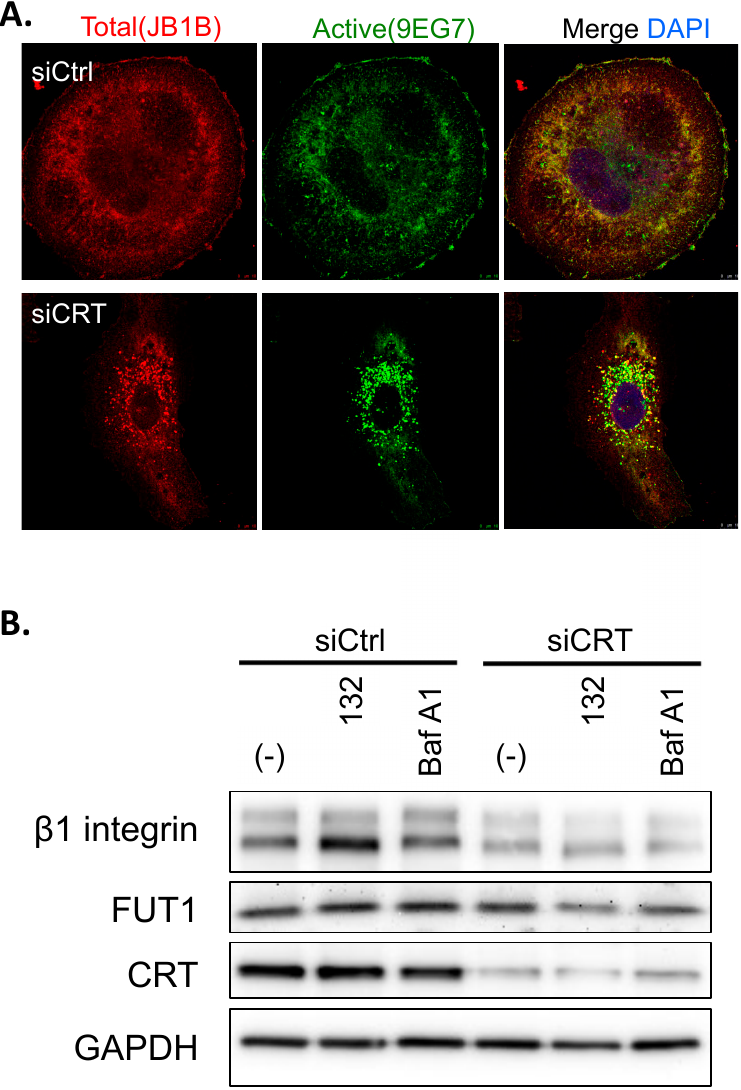
Figure 4. Knockdown of CRT induces β 1-integrin internalization. ( A ) Confocal images of total (JB1B, red) and active (9EG7, green) β 1-integrins in PC-3 transfected with siCRT or siCtrl. DAPI (blue) for nuclear staining. Scale bar = 5 μ m. ( B ) PC-3 cells were transfected with siCRT- or siCtrl for 36 h and then treated with protease inhibitor MG132 (10 μ M) or lysosome inhibitor Bafilomycin A1 (10 μ M) for 12 h. The expression levels of β 1-integrin, CRT, and GAPDH in PC-3 cell lysates were shown in Western blot images.